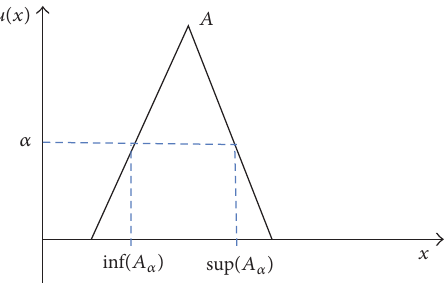
Figure 1: Membership function, infimum, and supremum for 𝛼